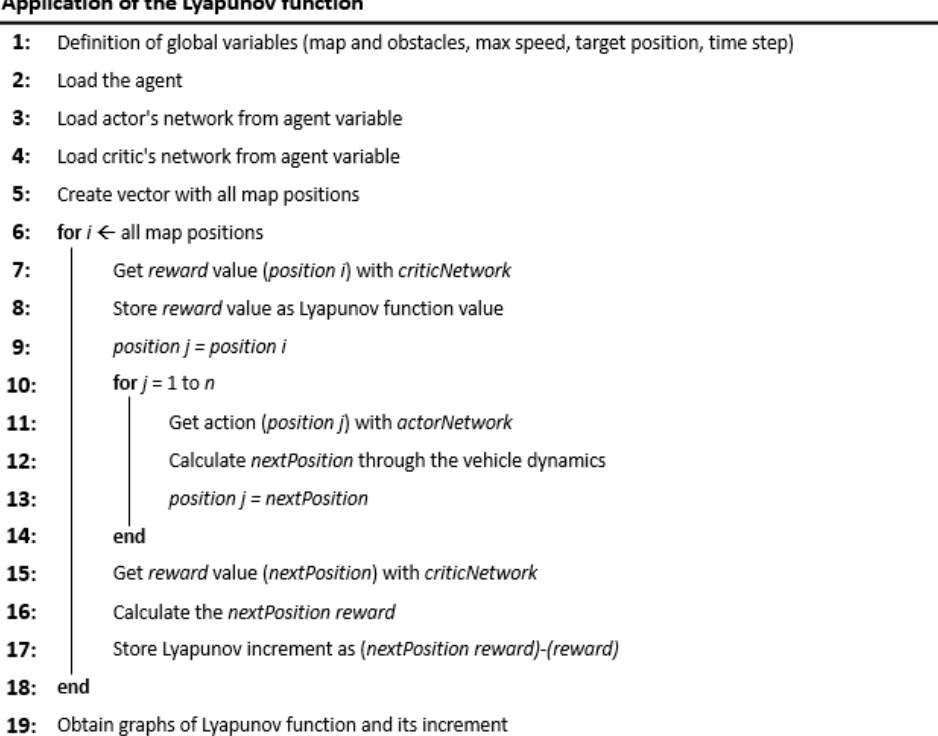
Figure 4. Pseudocode of Lyapunov function computation on the agent.